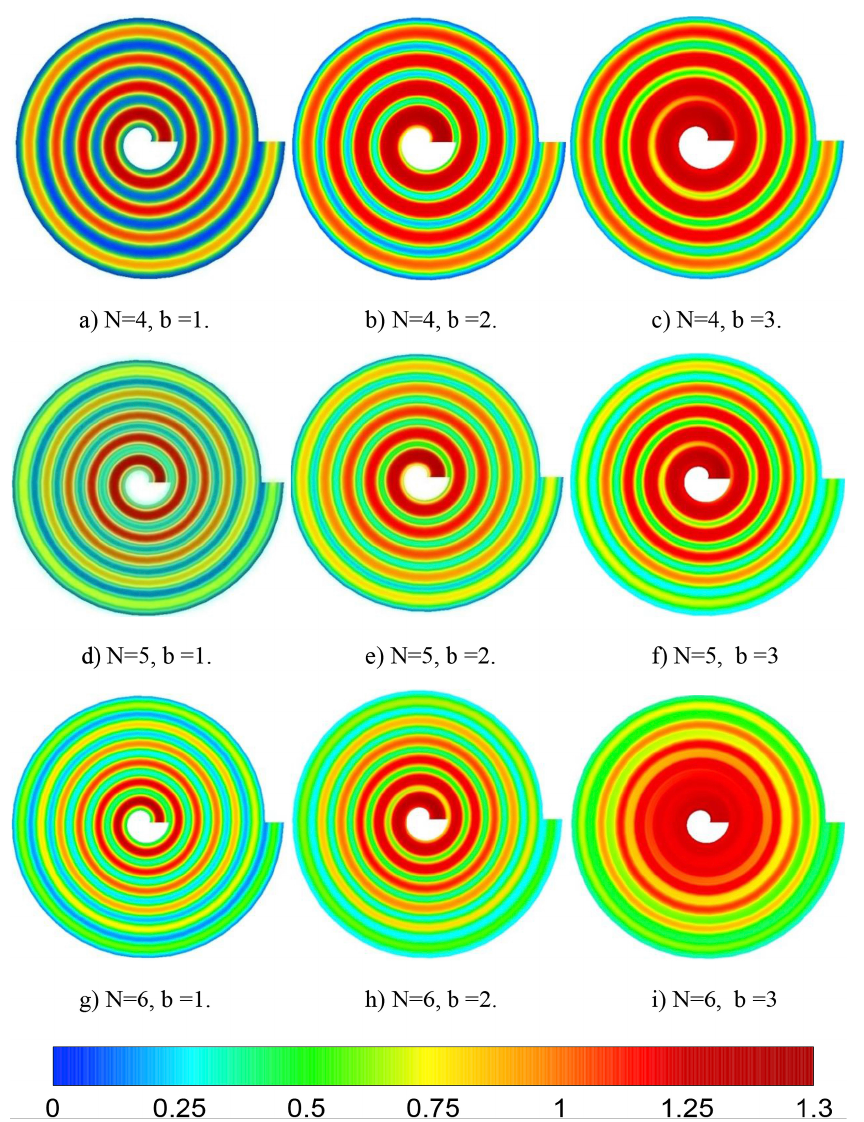
Figure 13. Hydrogen concentration field